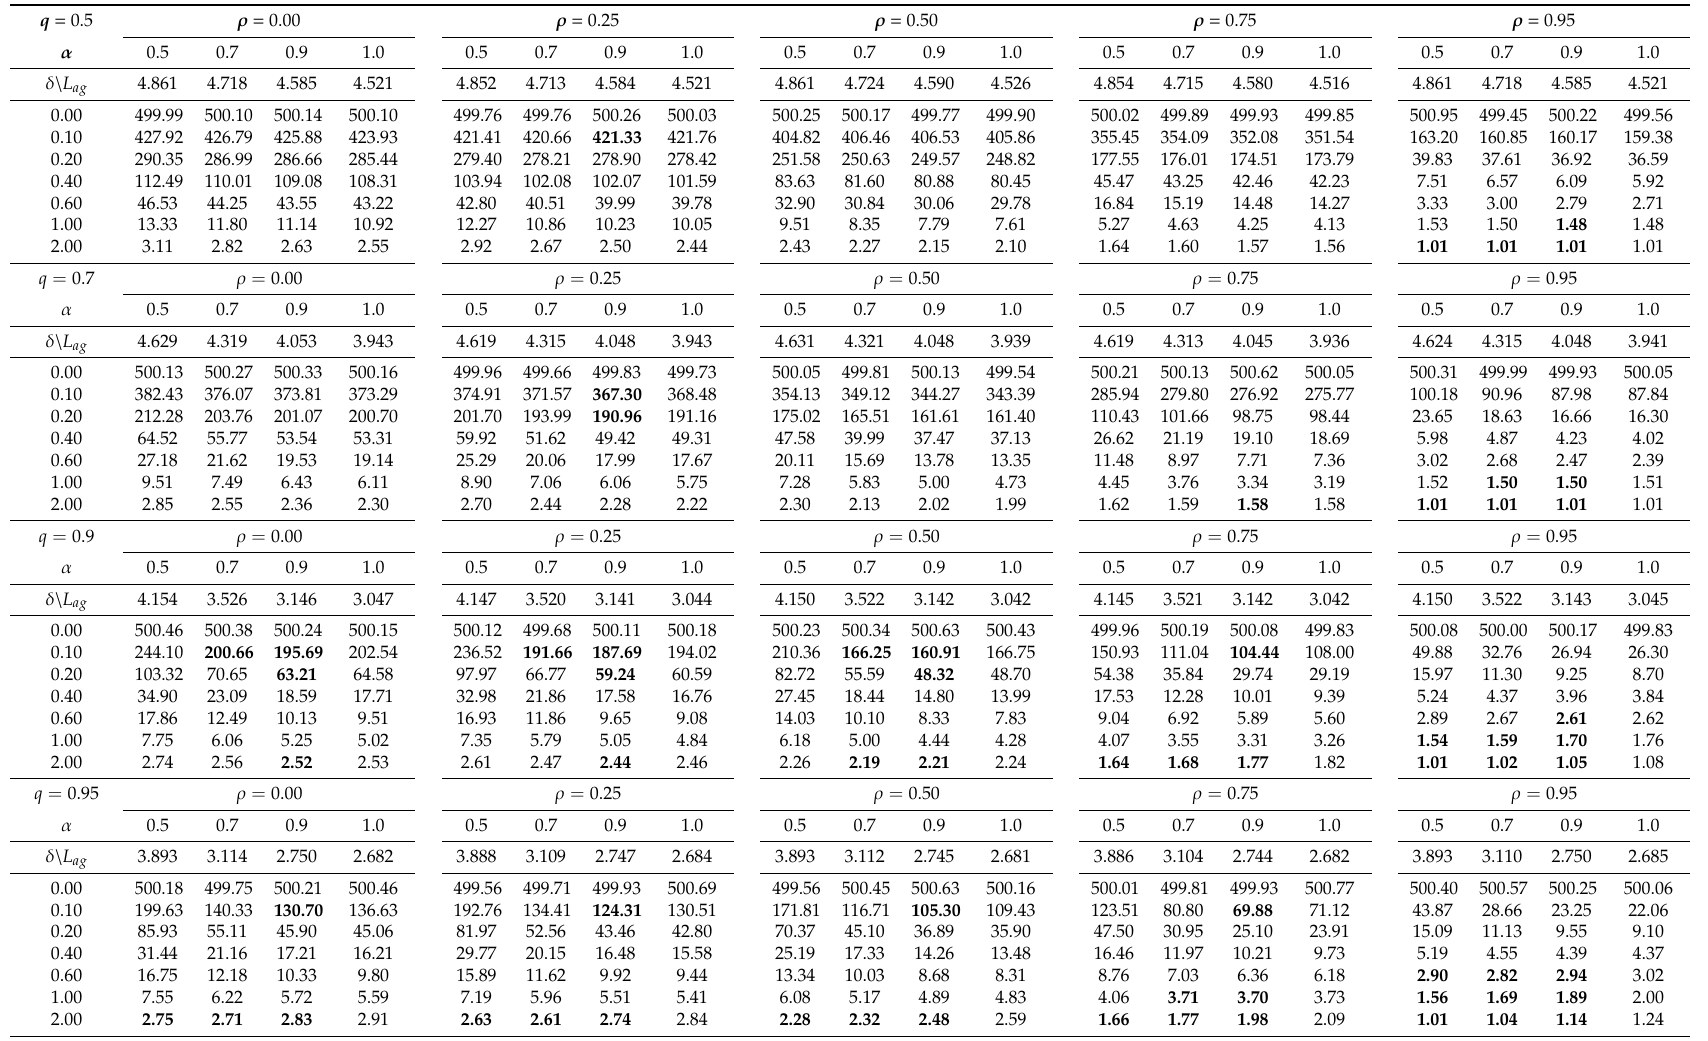
Table 2. Values for the AIB-GWMA-t charts when n =